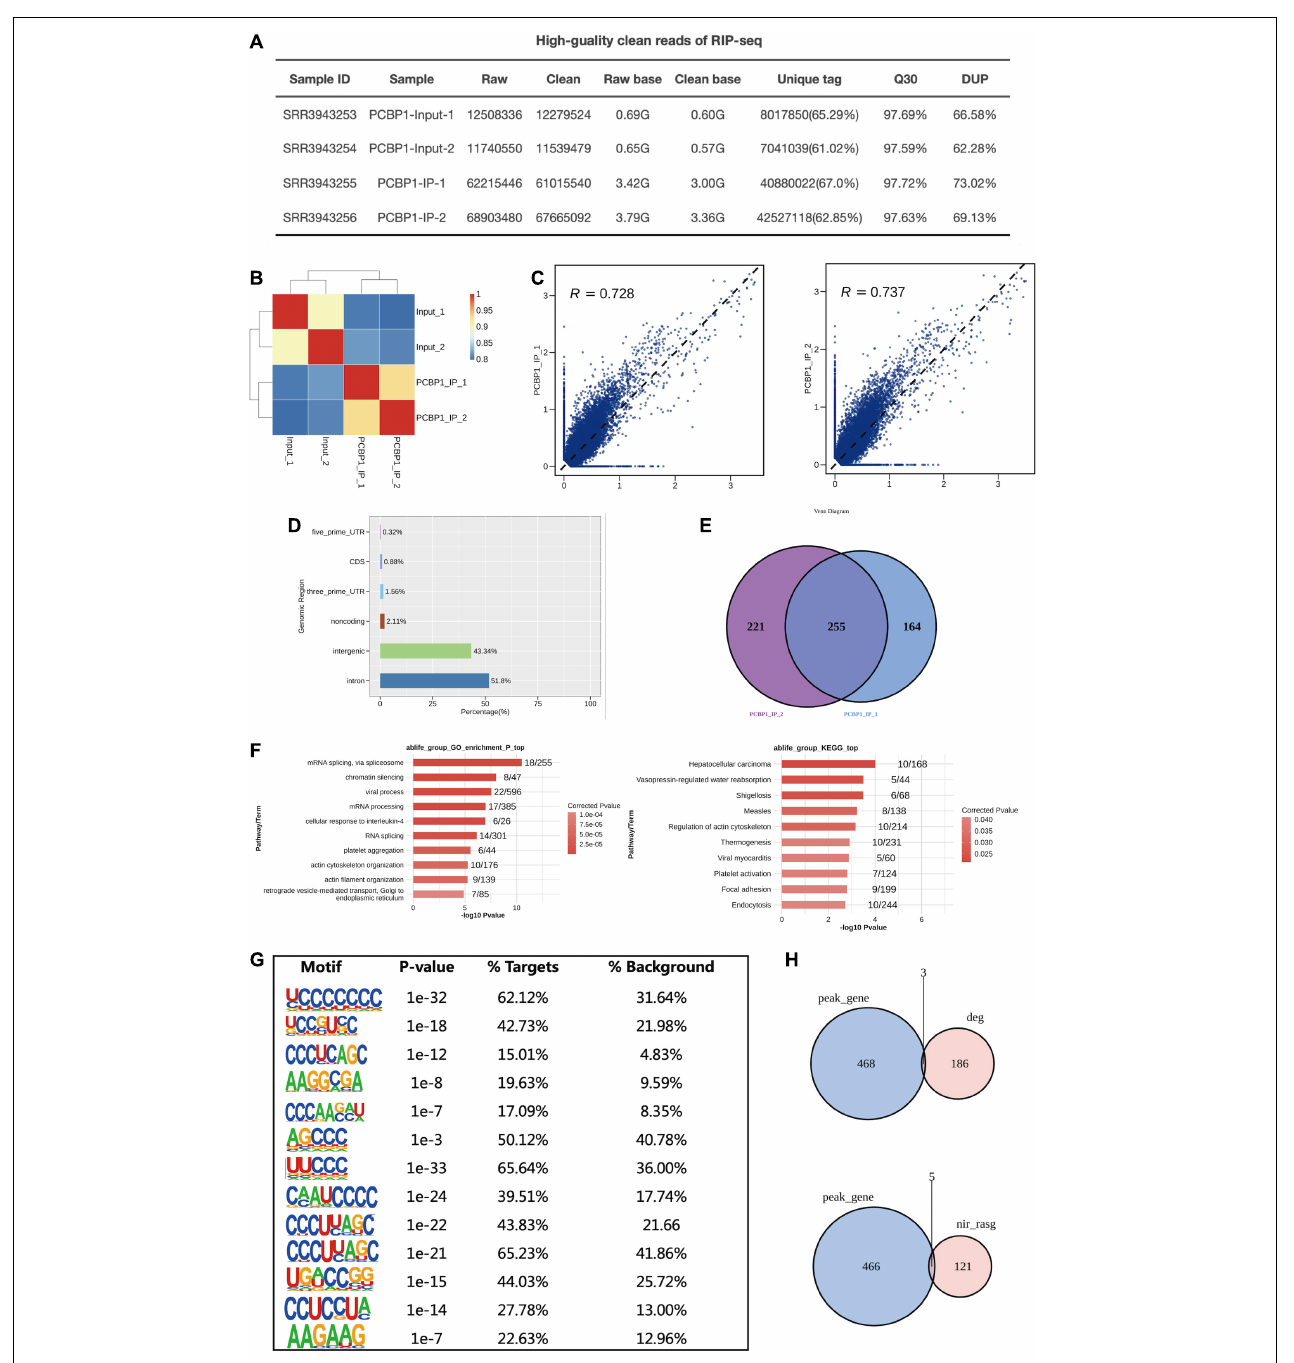
FIGURE 4 | PCBP-1 shows a strong association with RNAs from intergenic and intron regions. (A) The quality control of the CLIP sequence was good. (1) Raw data: the number of original sequences transformed from the original image data obtained by sequencing through base calling; (2) Clean reads: the raw reads were trimmed of the adapter sequences, and the number of valid sequences obtained after low-quality bases were used for subsequent analyses; (3) Raw base: the count of the number of bases it contained, based on the number and length of raw reads, in G; (4) Clean base: according to the number and length of clean reads, count of the number of bases it contained, in G; (5) Unique tag: unique tag, the number of non-repeating reads and its proportion of clean reads; (6) Q30: Proportion of bases whose sequencing error rate was less than 0.1%; (7) DUP: duplication level. The ratio of duplicate reads to total reads. (B,C) Heat map showing the hierarchically clustered Pearson’s correlation matrix resulting from a comparison of the transcript expression values for control and PCBP-1 immunoprecipitation (IP) samples. (D) Bar plot of the genomic region distribution of the control and uniquely mapped PCBP-1 IP reads. (E) Venn diagram analysis from the comparative results of ABLIRC peak calling methods. (F) GO and KEGG analyses from the comparative results. (G) Extracted PCBP1 peaks motifs using ABLIRC Methods. (H) Venn diagram from overlapping analysis results for GSE84700 CLIP-seq data with PCBP1 OE RNA-seq using ABLIRC analysis methods.